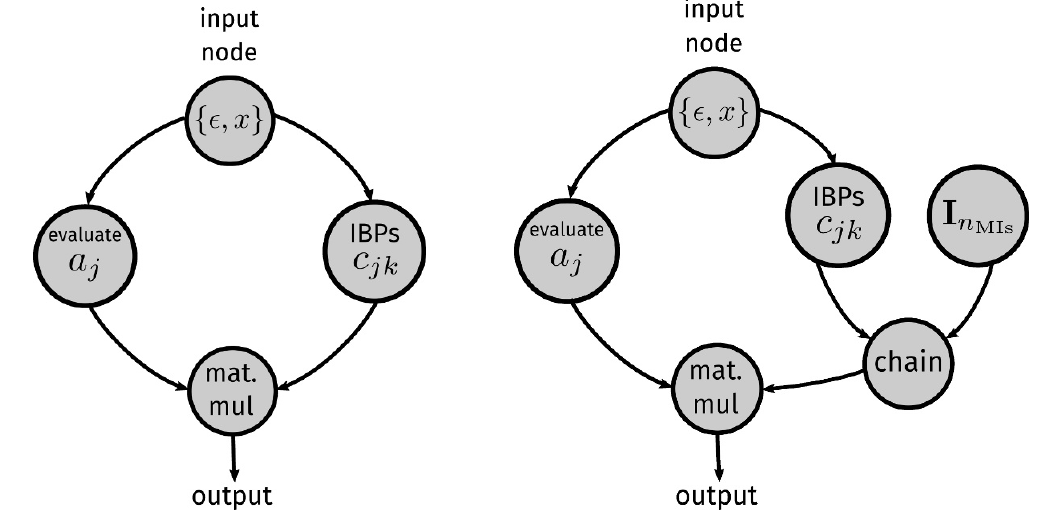
Figure 5 . Two data(cid:13)ow graphs representing the reduction of a scattering amplitude to master integrals. The graph on the right has two additional nodes chaining to the coe(cid:14)cients of the IBP solutions an identity matrix, which represents the (trivial) reduction of the master integrals themselves. These nodes are needed when the masters can also appear on the r.h.s. of the unreduced amplitude in eq.